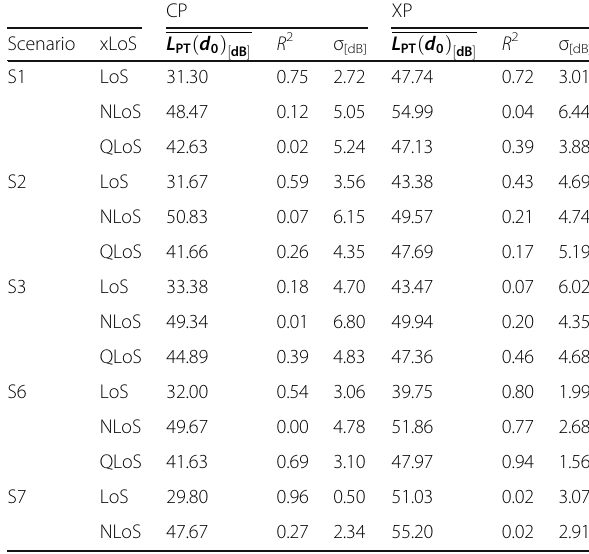
Table 5 Mean path loss for CP/XP channel, body B1 ( n = 1.71) CP XP